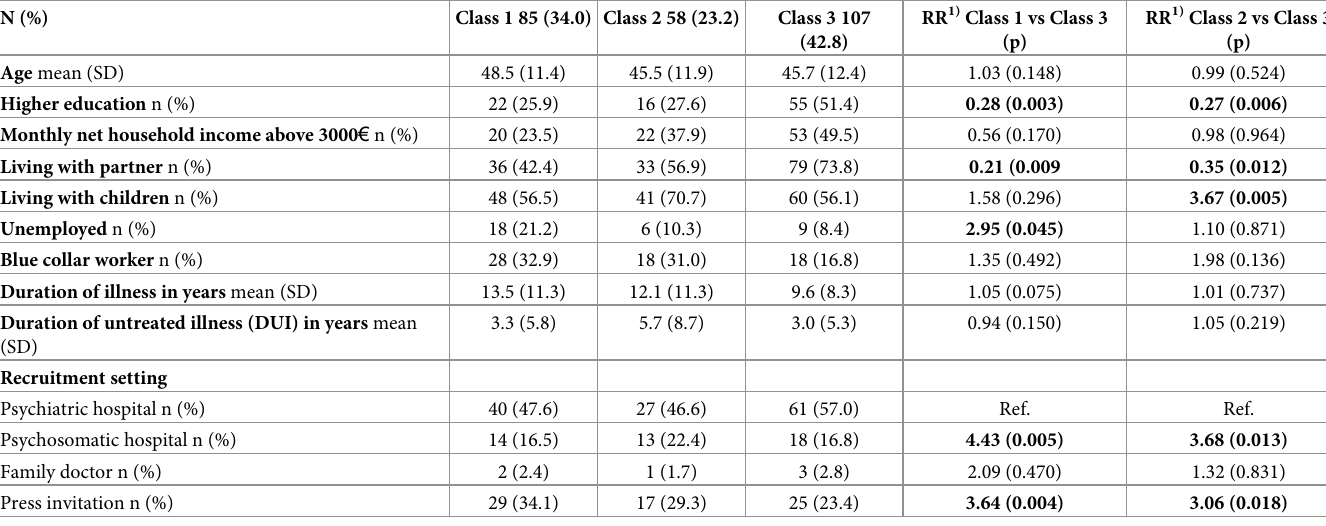
Table 3. Multi-nomial logit regression model of latent class assignment on sociodemographic characteristics, duration of illness and recruitment